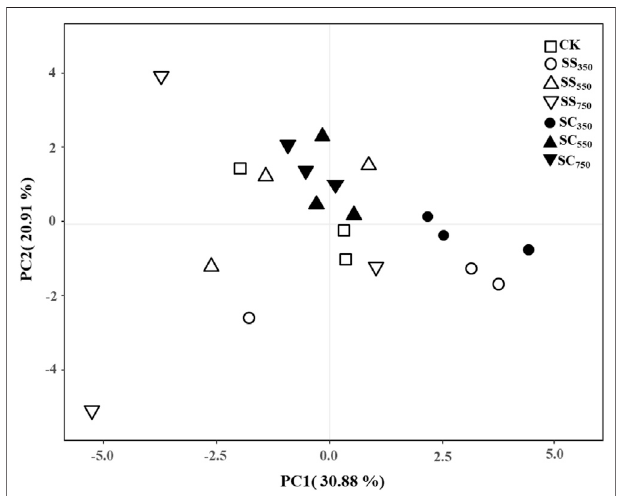
FIGURE 4 | Principal component analyses of the soil microbial community structure.